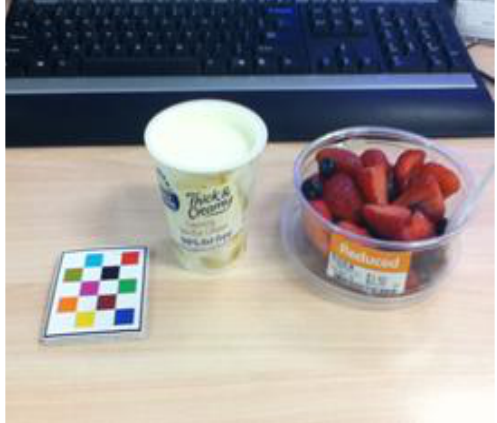
Figure 1. Example of assessment of individually packaged foods using the mobile food